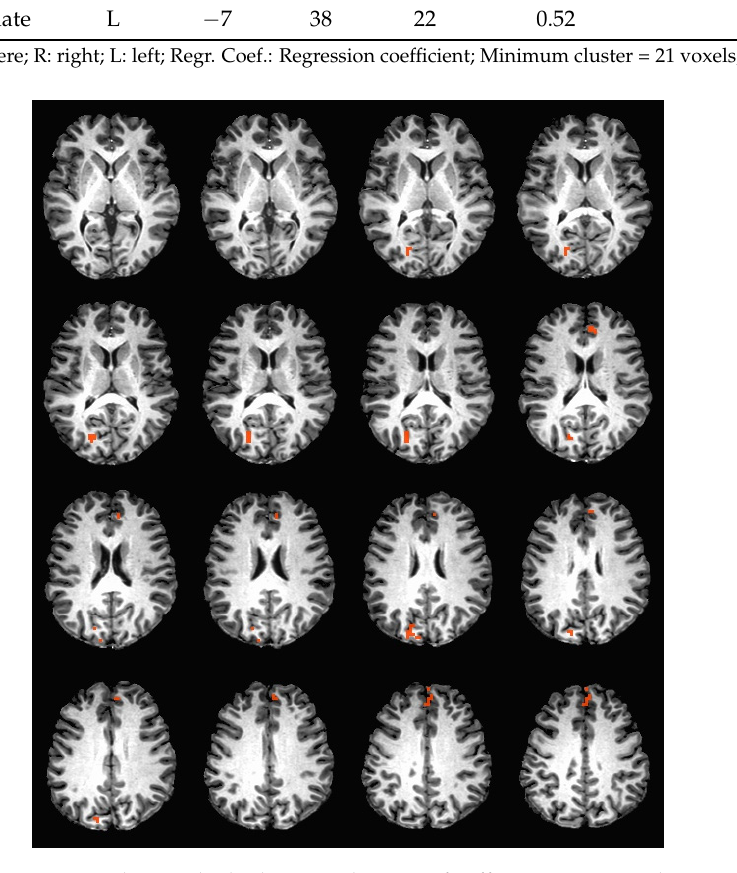
Figure 2. Brain activation during the hedonic evaluation of caffeine. Orange indicates areas where caffeine non-consumers had significantly greater activation in comparison to caffeine consumers. During the hedonic evaluation of saccharin, caffeine non-consumers had significantly lower neuronal activation than caffeine consumers in the middle temporal gyrus, inferior temporal gyrus, middle occipital gyrus, right fusiform gyrus, right lingual gyrus, and right cuneus (See Table 5 and Figure 3). Table 5. Regions of significantly greater activity in caffeine consumers compared to caffeine non- consumers while judging the pleasantness of saccharin.